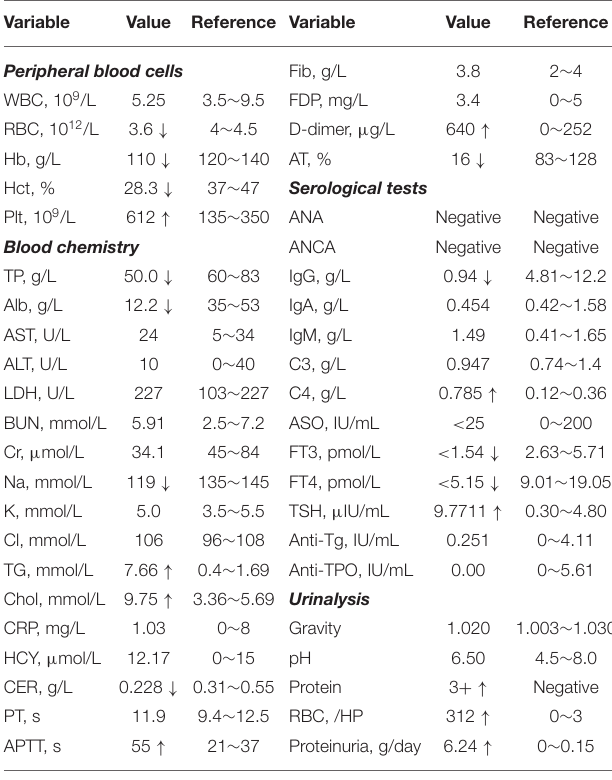
TABLE 1 | Laboratory results of the child at